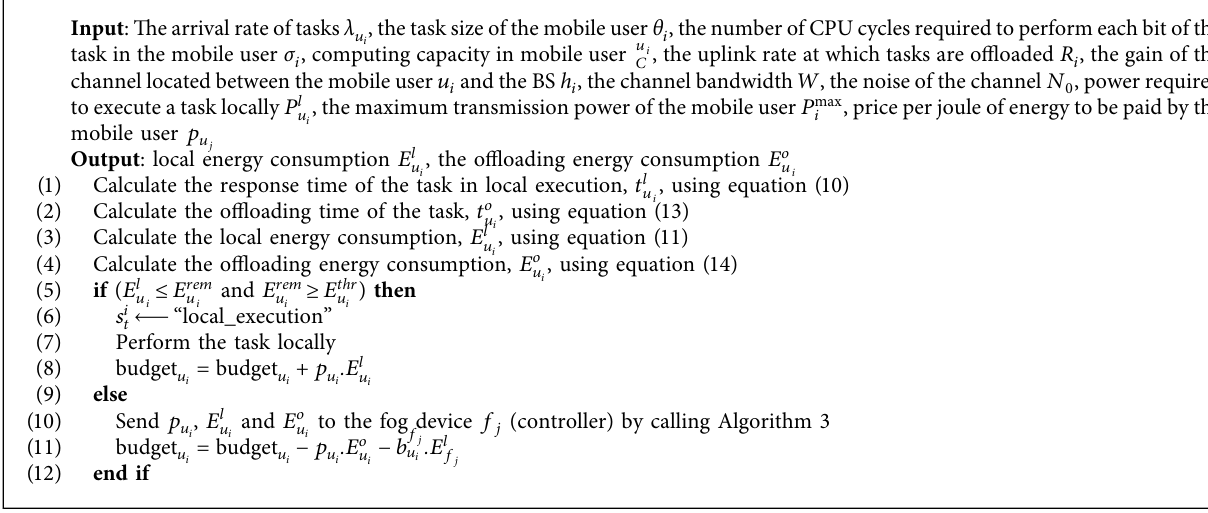
A LGORITHM 2: Pseudocode of a mobile user u i in the proposed ofoading